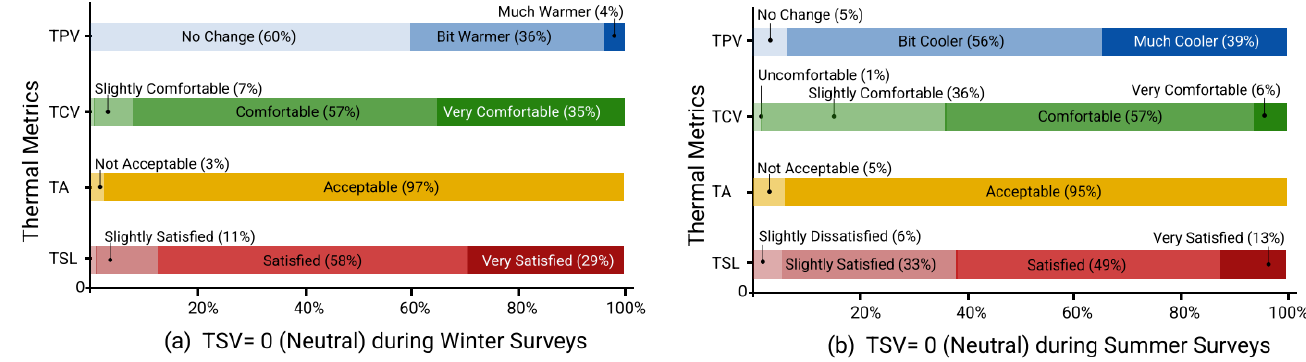
Figure 4. Other Thermal Metrics for TSV = 0 (neutral) during Winter and Summer